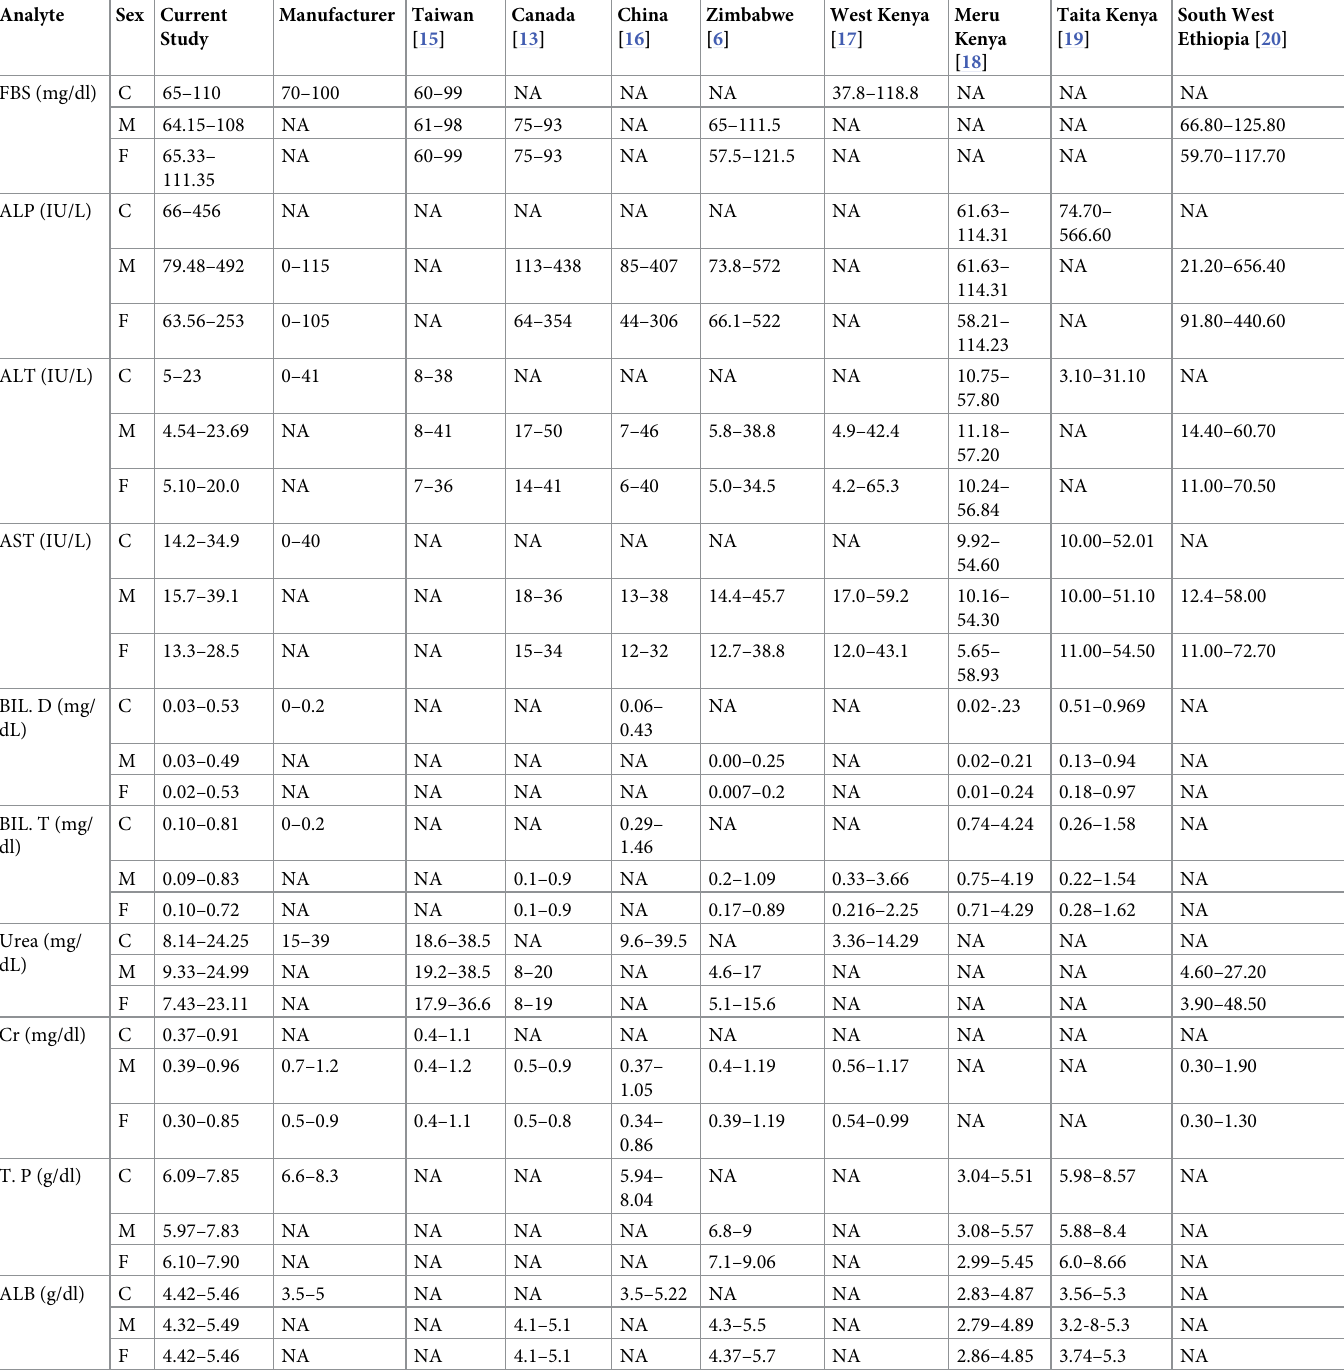
Table 4. Comparison of clinical chemistry parameters RI of current study against manufacturer ranges and other similar